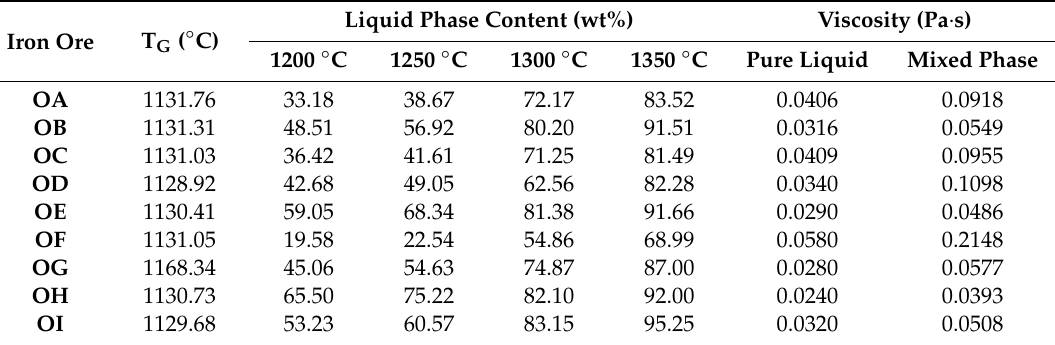
Table 3. Calculation results of thermodynamic equilibrium and